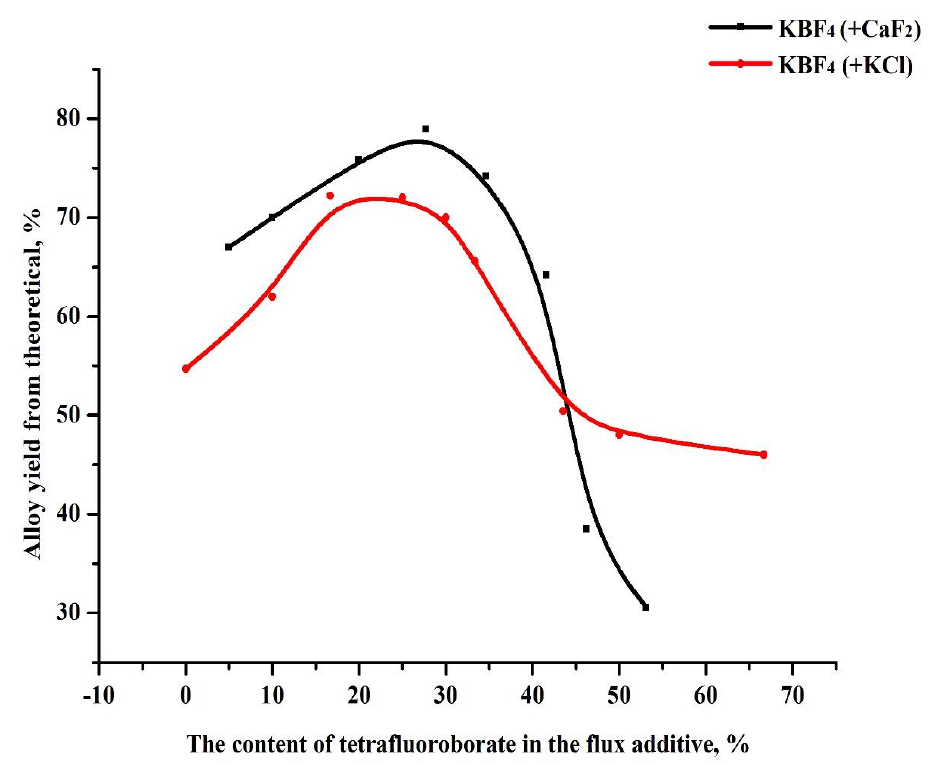
Figure 4. Dependence of the output of the boride alloy on the use of mixed fluxing additives from chloride and fluoride salts.